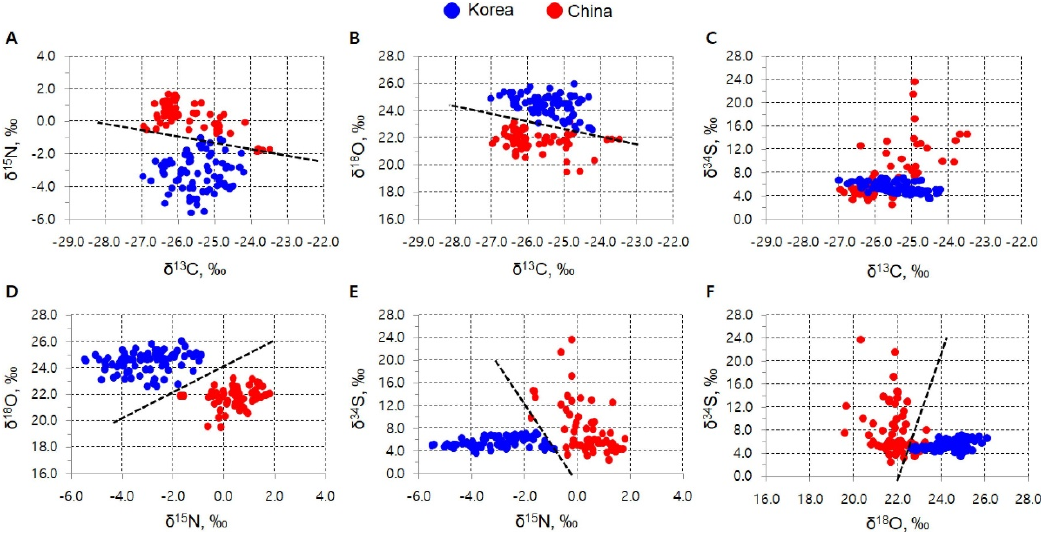
Figure 6. 2D plots of ( A ) δ 13 C vs. δ 15 N, ( B ) δ 13 C vs. δ 18 O, ( C ) δ 13 C vs. δ 34 S, ( D ) δ 15 N vs. δ 18 O, ( E ) δ 15 N vs. δ 34 S, and ( F ) δ 18 O vs. δ 34 S values of the sliced shiitake mushrooms from Korea (blue) and China (red) (Source: [39]).